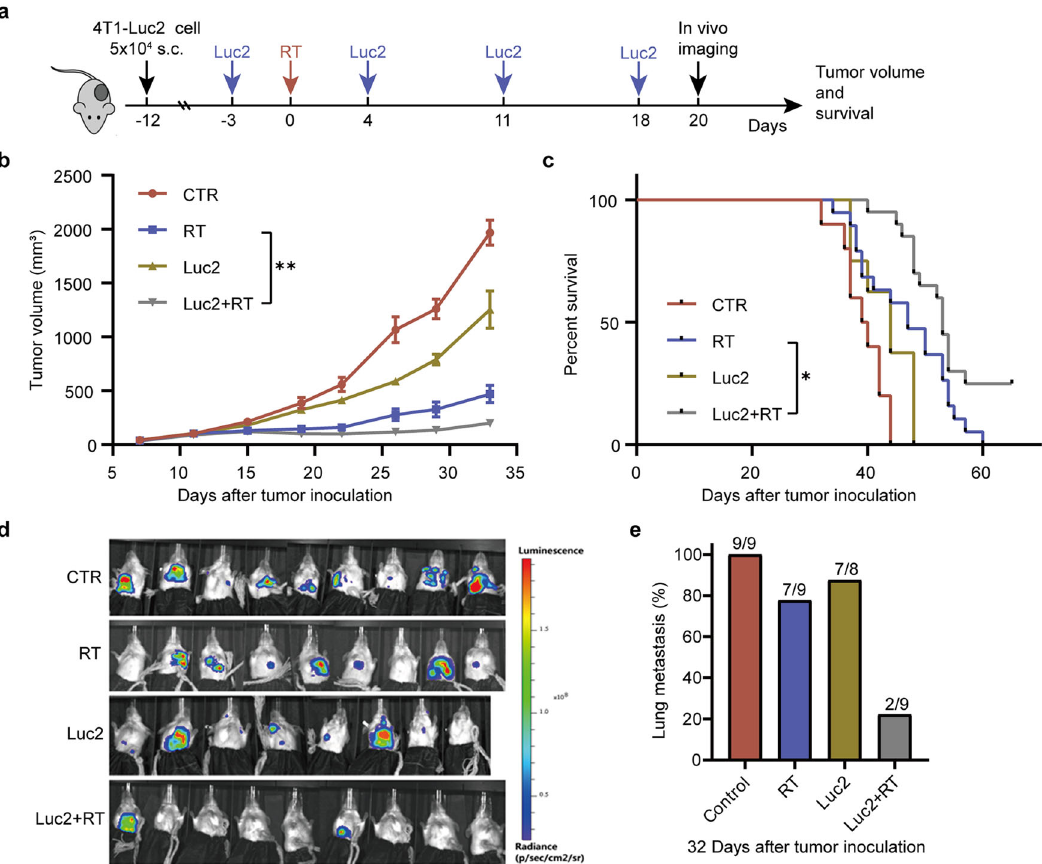
Fig. 7 The combination therapy of Luc2 vaccine followed by RT effectively prevented lung metastases of 4T1-Luc 2 tumor. 4T1-Luc 2 cells (5 × 10 4 cells/mouse) were inoculated on the forth fat-pad of BALB/c mice. a Experimental procedure: tumor-bearing mice received the fi rst dose of Luc2 vaccine (6 μ g per mouse) on day 9 after tumor cells injection, then on day 12 the tumors were irradiated, another three doses of E7 vaccines were administrated subcutaneously (sc.) on day 4, 11, and 18 after RT. b Tumor volume in 4T1-Luc2 tumor-bearing mice over time. c Survival curves of the 4T1- Luc2 tumor-bearing mice with various treatments. Results are presented as mean ± SD, 8 – 9 mice for each treatment. d Bioluminescence imaging of 4T1- Luc2 breast cancer lung metastasis on day 23 after RT in vivo using IVIS. e The incidence of lung metastases of the mice received various treatments. Experiments were repeated two times and two-tailed t -test was used for two-way comparisons of biological replicates. * P < 0.05, ** P < 0.01, *** P < 0.001, **** P <